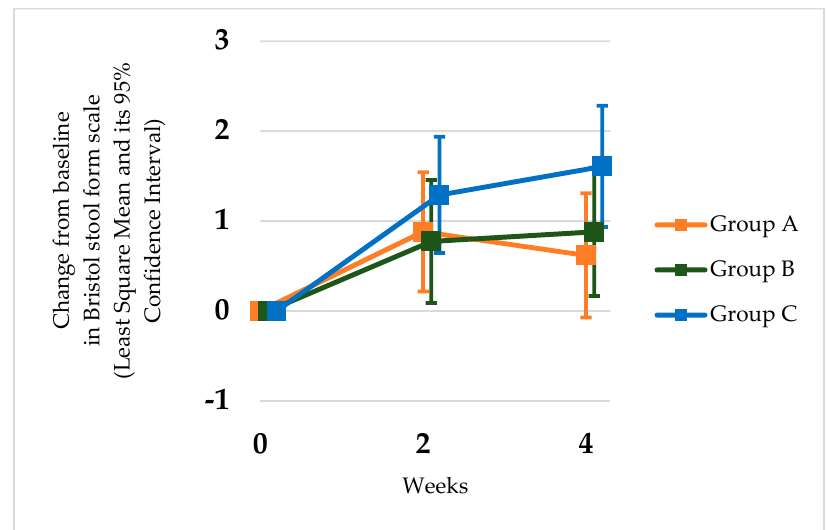
Figure 2. Change from the baseline in the Bristol stool form scale in the groups administered Lactobacillus reuteri DSM 17938 (group A), combination (group B), and magnesium oxide (group C). Time course of the comparison of the differences in the Bristol scale at weeks 2 and 4 after the initiation of the treatment. The Bristol stool form scale was increased at weeks 2 and 4 in the combination and magnesium oxide groups compared with the baseline, but the probiotic group did not show any significant changes at week 4.